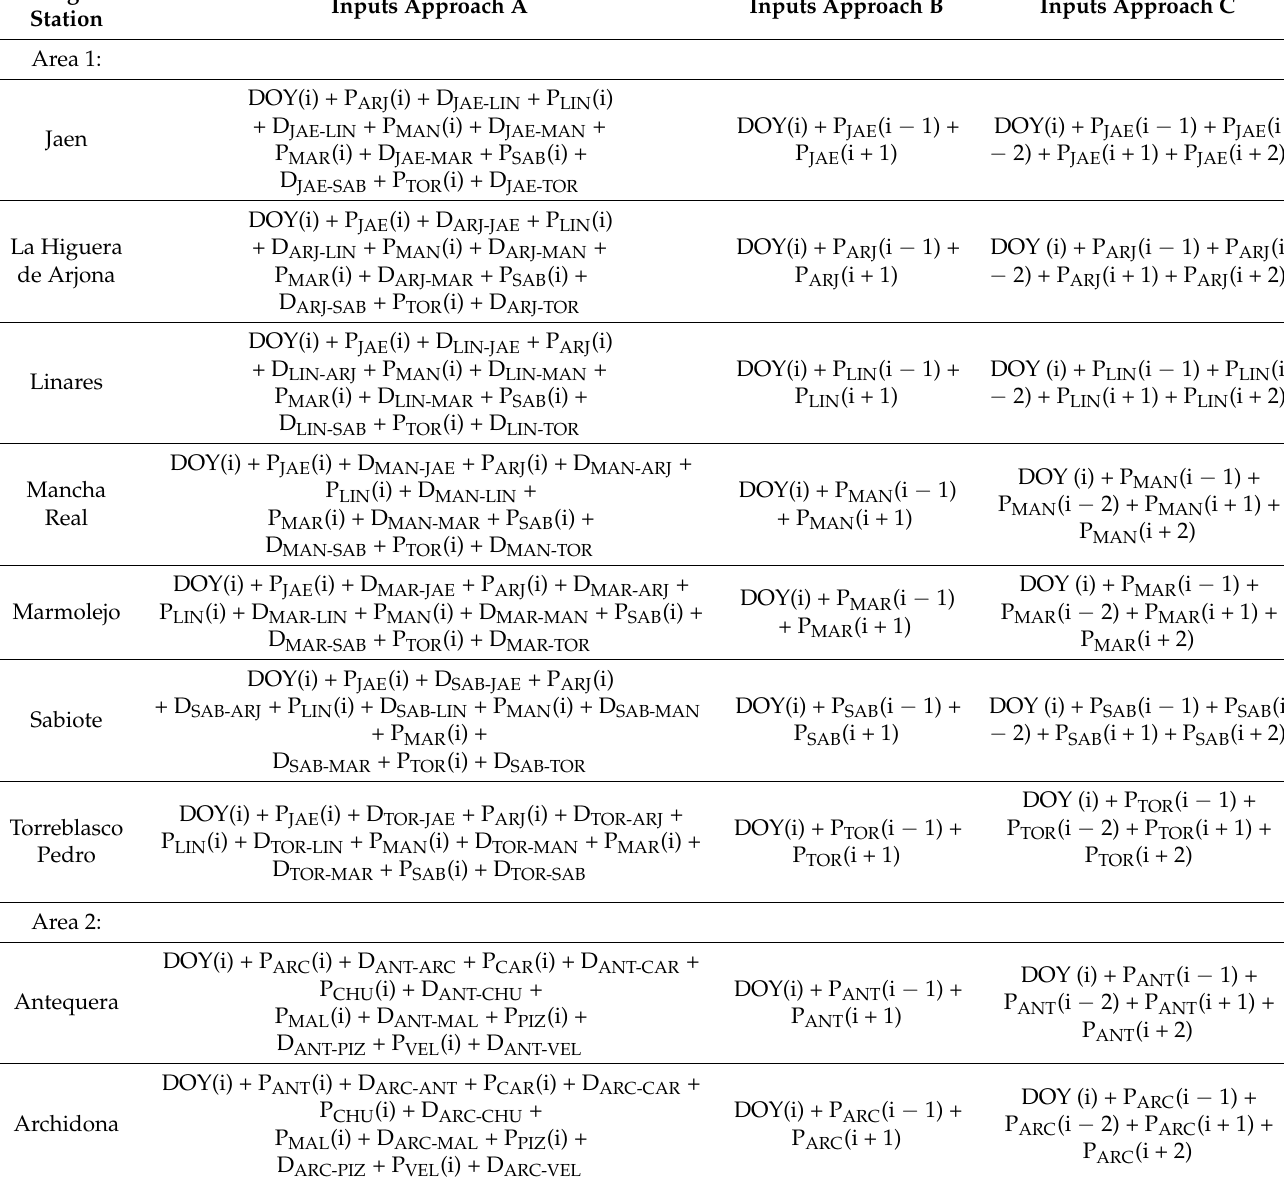
Table 2. Inputs configurations of the different models and approaches assessed. DOY represents the day of year, P corresponds to precipitation, D corresponds to distance, and i represents an index to the dataset-specific day. Target Inputs Approach A Inputs Approach B Inputs Approach C Station Area